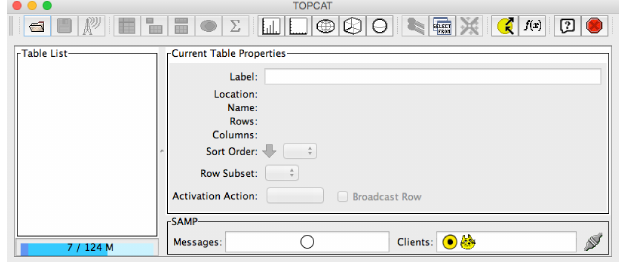
The name of the table file, the number of rows and the number of columns are displayed, and some of the icons that were initially greyed out (because they only work once a table is loaded) are now accessible. By clicking on the “View table data” icon (cf. Fig. 51) or by going to the top menu, choosing the “Views” drop-down menu and clicking “Table Data”, you can get an overview of your table data, column names included, in a new window, as in Fig.